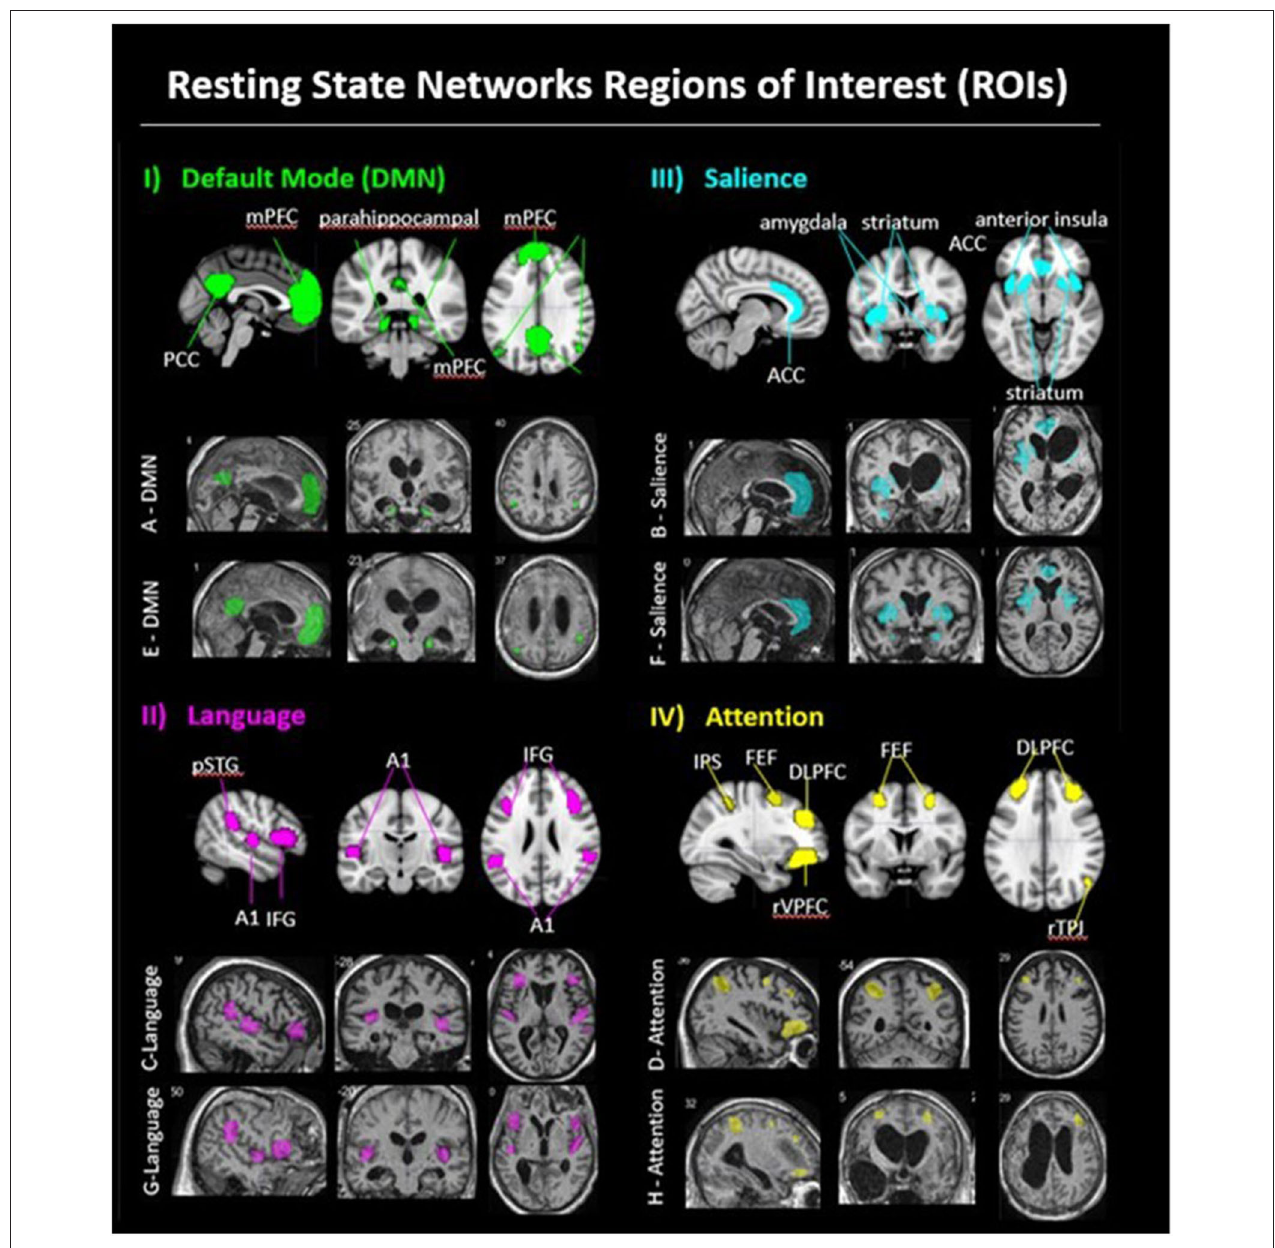
FIGURE 1 | Resting state networks regions of interest (ROI). (i) DMN: Panel I, row 1 shows a DMN exemplar on the MNI 152 standard brain, with medial prefrontal cortex (mPFC), posterior cingulate cortex (PCC), bilateral parahippocampal area, bilateral temporal parietal junction (TPJ). Panel I, row two shows example of a FAST subject’s DMN ROIs (patient A); panel I. row 3 shows an example of a placebo subject’s DMN ROIs (patient E). (ii) Language: Panel II, row 1 shows the language network ROIs on the MNI 152 standard brain, with bilateral posterior superior temporal gyrus (pSTG; Wernicke area), bilateral primary auditory cortex (Heschl gyrus), and bilateral inferior frontal gyrus (IFG; Broca area). Panel II, row 2 shows an example of a FAST subject’s language ROIs (patient C); panel II, row 3 shows an example of a placebo subject’s language ROIs (patient G). (iii) Salience: Panel III, row 1 shows the salience network ROIs on the MNI 152 standard brain, with anterior cingulate cortex (ACC), bilateral amygdala, bilateral anterior insula, and bilateral striatum. Panel III, row 2 shows an example of a FAST subject’s salience ROIs (patient B); panel III, row 3 shows an example of a placebo subject’s salience ROIs (patient F). (iv) Attention: Panel IV, row 1 shows the attention network ROIs on the MNI 152 standard brain, including bilateral dorsal lateral prefrontal cortex (DLPFC), bilateral frontal eye fields (FEF), bilateral intraparietal sulcus (IPS), right temporal parietal junction (rTPJ), and right ventral lateral prefrontal cortex (rVLPFC). Panel IV, row 2 shows an example of a FAST subject’s attention ROIs (patient D); panel IV, row 2, shows an example of a Placebo subject’s attention ROIs (patient